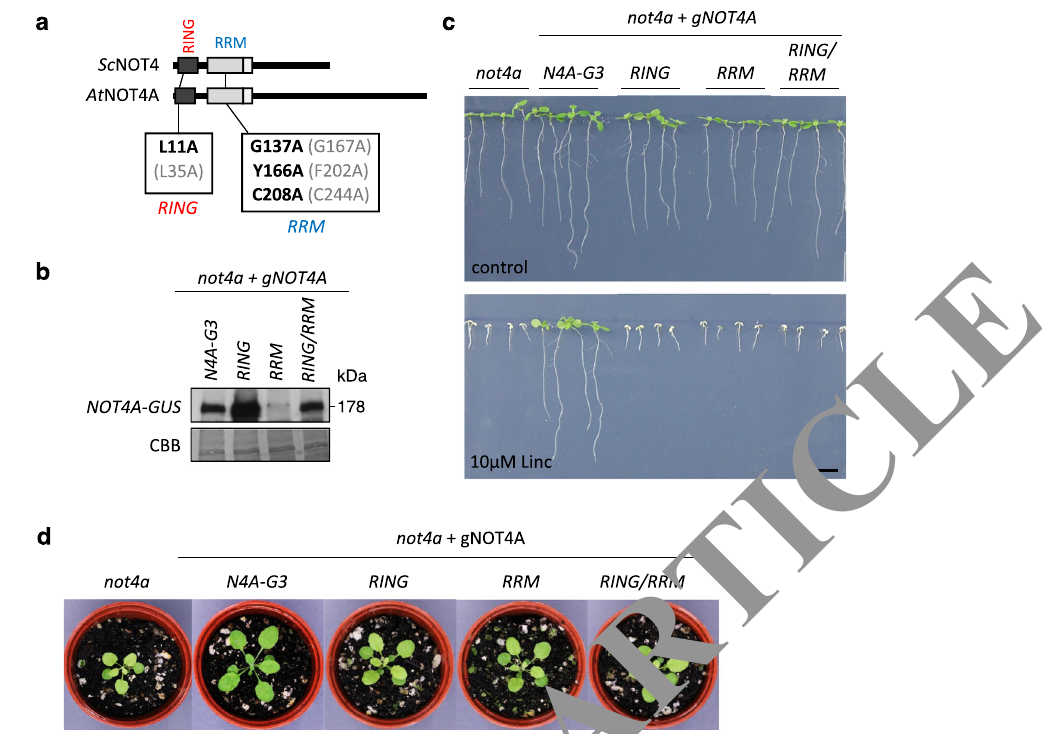
Fig. 5 Functional domain analysis of NOT4A. a Schematic diagram showing position of point mutations in RING and RRM domains. Mutations in black are those introduced to the NOT4A gene, which correspond to equivalent conserved residues in Sc NOT4 (shown in grey), additionally highlighted in Supplementary Fig. 1 sequence alignments. b anti-GUS western blot of steady state levels of pNOT4A::NOT4A -GUS variants expressed in not4a . Blots were repeated at least three times with similar results. c 10-day-old not4a and pNOT4A::NOT4A -GUS complementation lines grown on vertical plates ±10 µ M lincomycin. Bar = 1 cm. d Representative rosette images of 3-week-old not4a and pNOT4A::NOT4A -GUS complementation lines under long day (LD) conditions. Bar = 1